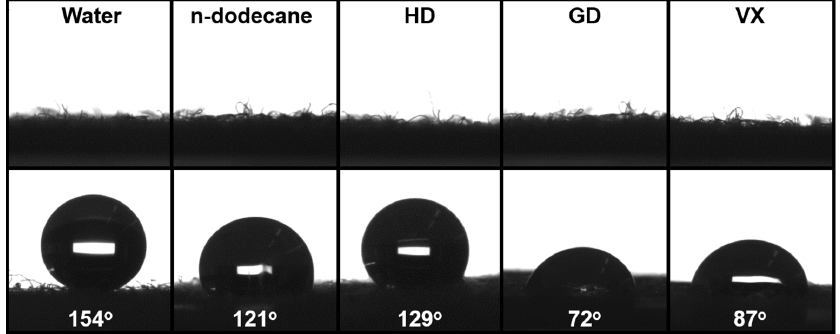
Figure 5. The images and contact angles of static droplets on raw cotton fabric ( Top ) and OmniBlock-coated cotton fabric ( Bottom ) from the drop shape analyzer. Water (5 µ L) at θ = 154 ◦ , n-dodecane (5 µ L) at θ = 121 ◦ , HD (3 µ L) at θ = 129 ◦ , GD (3 µ L) at θ = 72 ◦ , and VX (3 µ L) at θ = 87 ◦ .